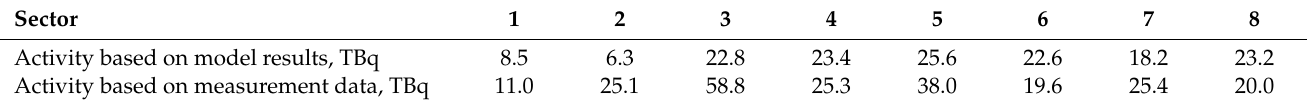
Table 3. Calculated and measured total activities of 137 Cs in bottom sediments in eight sectors of the CP in